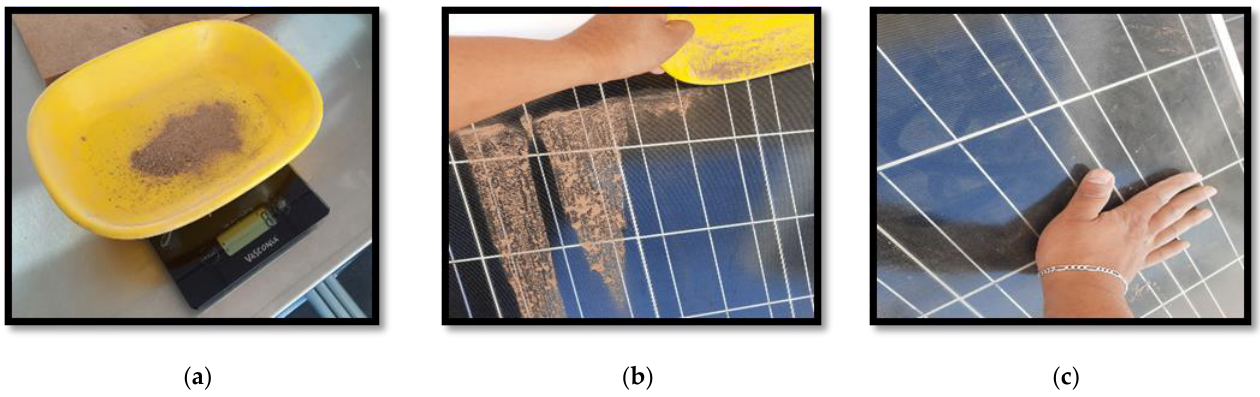
Figure 6. Procedure for the generation of the dust accumulation conditions in the PV panels; (a) dust layer weighing, (b) deposition of the dust over the panel surface and, (c) uniform spread of the dust layer over the panel surface.